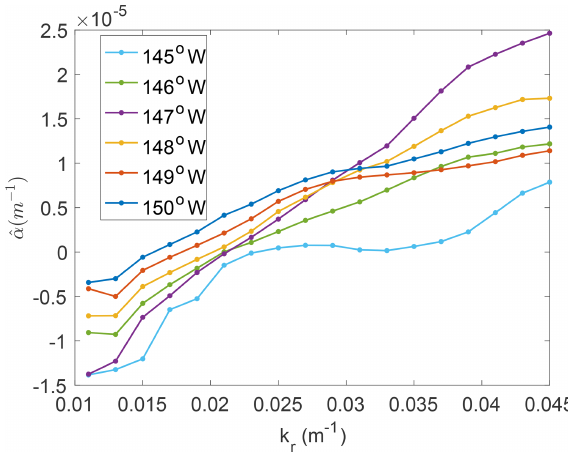
Figure B2. ˆ α against k r of different longitude